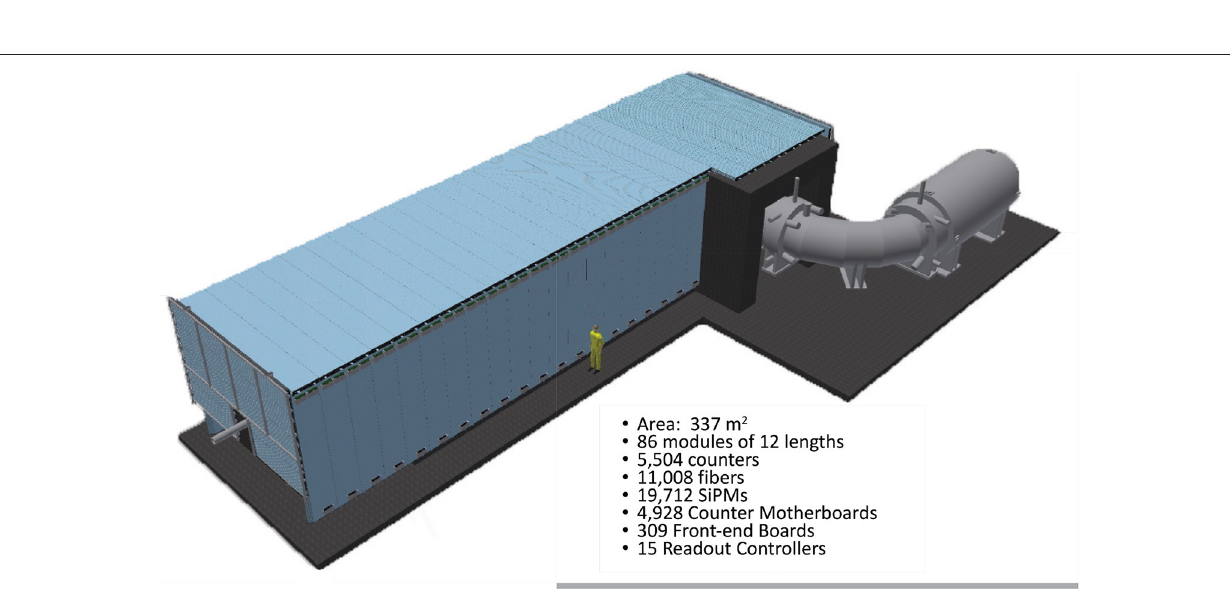
Frontiers in Physics |